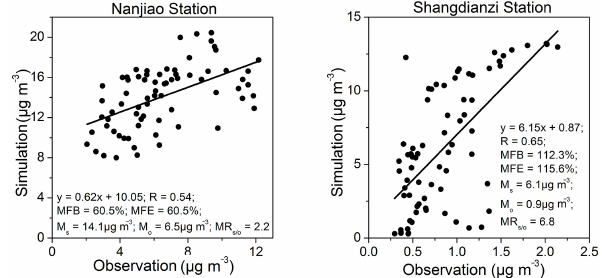
Figure 5. Comparisons of observed and modeled hourly BC concentrations at Nanjiao and Shangdianzi stations from 20:00 1 July 2008 to 19:00 4 July 2008. Statistical parameters used are mean functional bias (MFB), mean functional error (MFE), mean value of the simulated ( M s ) , mean value of the observed ( M o ) and Mean ratio of the simulated to the observed ( M s/o )